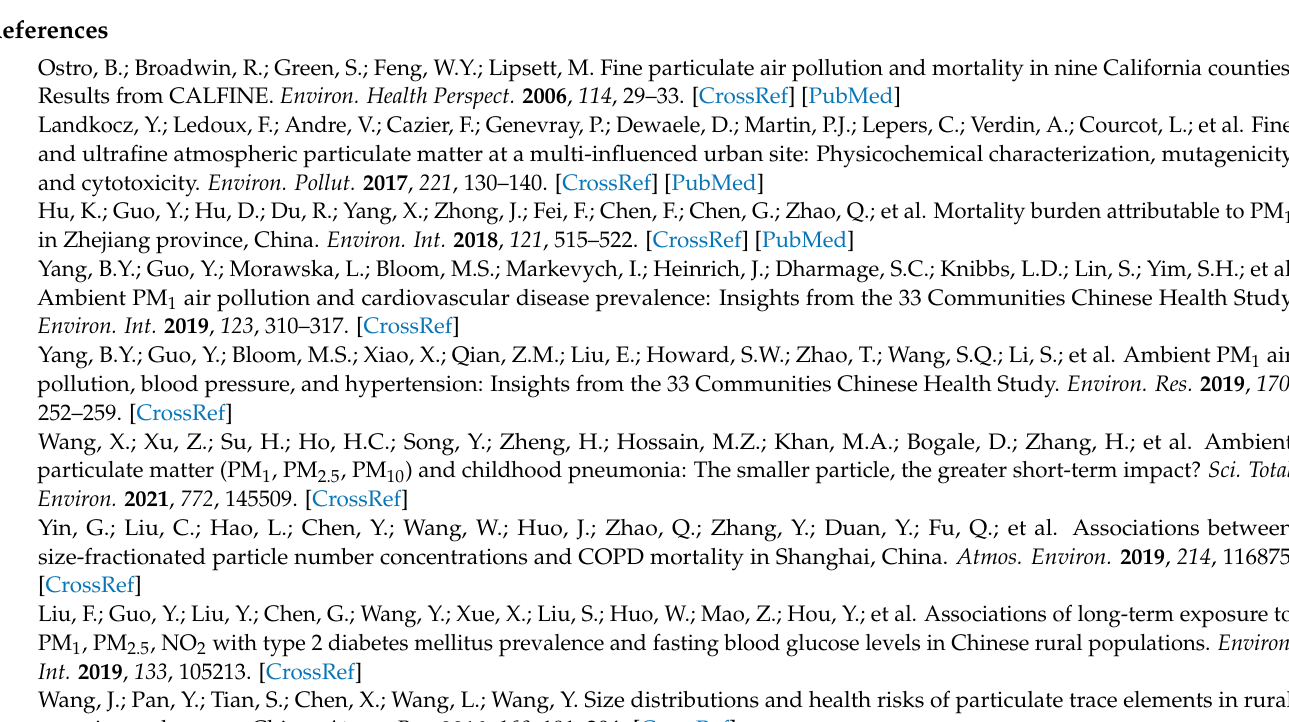
Table S3: The proportion of heavy metals in PM 2.5 and PM 1 from four seasons; Table S4: Average concentrations of OCEC in PM 2.5 and PM 1 from four seasons; Table S5: Correlation coefficients Table S6: The nomenclature table in the